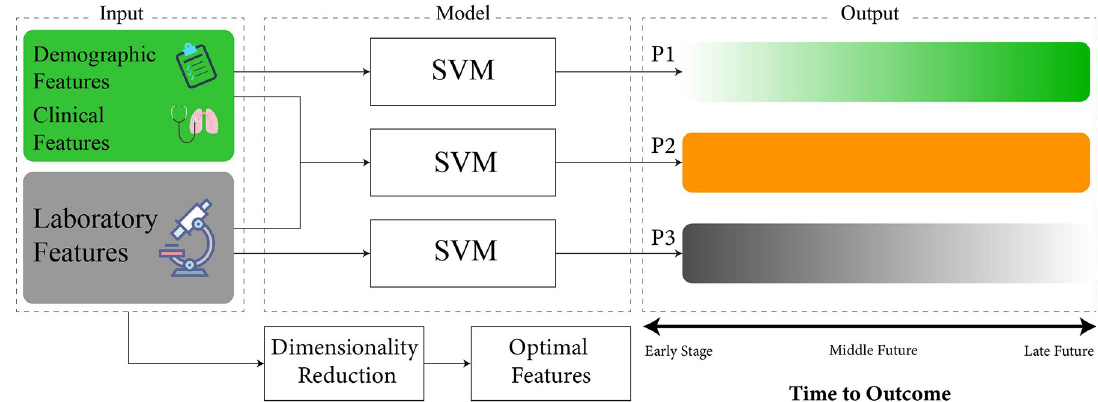
Fig 1. Illustration of the modeling framework. Three machine learning models were developed using the SVM framework with three input groups; invasive, non-invasive, and their combination. The invasive group comprises laboratory results. Non-invasive features comprise patient clinical and demographic data. The joint group comprises the combination of invasive and non-invasive features. P1, P2, and P3 represent the prediction performance provided by the non-invasive, joint, and invasive models, respectively. The non- invasive model displayed good prediction performance in the farther future (P1) whereas the invasive model showed good prediction performance for the near future (P3). Neighborhood Component Analysis (NCA), recursive feature elimination via Support Vector Machine (SVM-RFE), and linear SVM with least absolute shrinkage and selection operator (Lasso) sparsity regularization (Sparse Linear SVM) were utilized for inspection of feature contributions and dynamics with respect to the outcome.